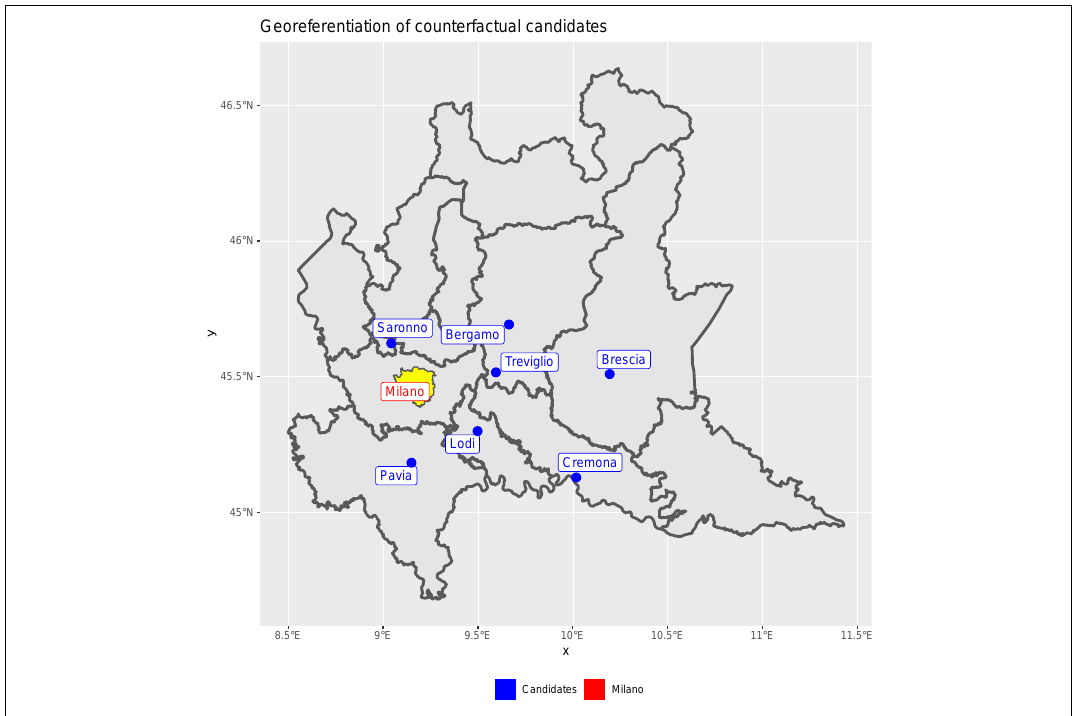
Figure 3. Georeferentiation of counter-factual candidates. Geographical positioning of the counter- factual candidates with respect to Milan. Observed concentrations (1 January 2014 − 30 September 2019) Nitrogen Oxides: NO x Nitrogen Dioxide: NO 2 with yearly average (solid lines) and yearly median (dashed) with yearly average (solid lines) and yearly median (dashed lines)